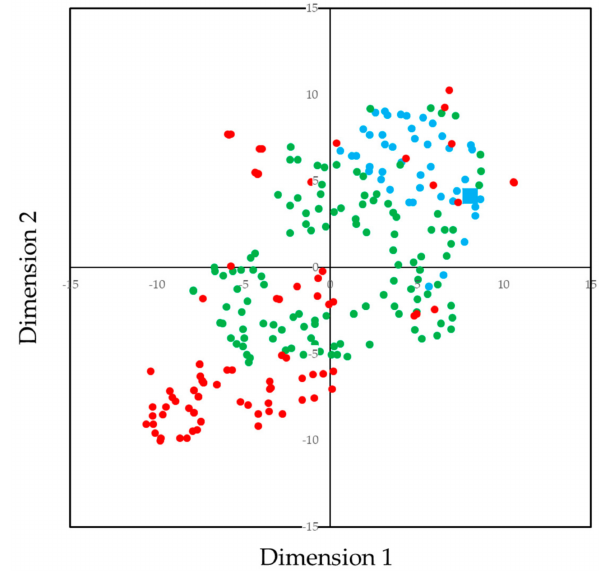
Figure 6. The t-Distributed Stochastic Neighbor Embedding (tSNE) plot for the prevalence of dental caries categorized by Groups. Group 1: No dental caries, Group 2: Dental caries in molar teeth or dental caries in maxillary anterior teeth, Group 3: Dental caries in both molar and maxillary anterior teeth, Group 4: Dental caries in mandibular anterior teeth. The tSNE analysis embeds high-dimensional